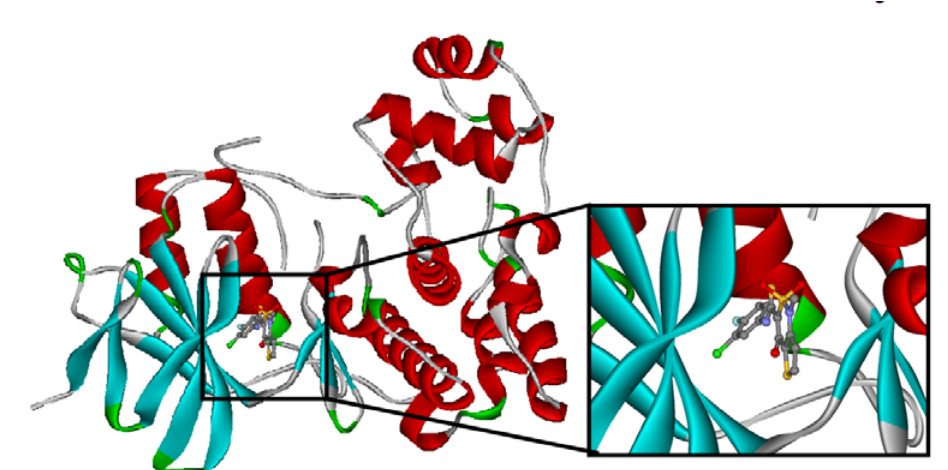
Figure 4. Binding site of the native Z1208 JNK3 complex.